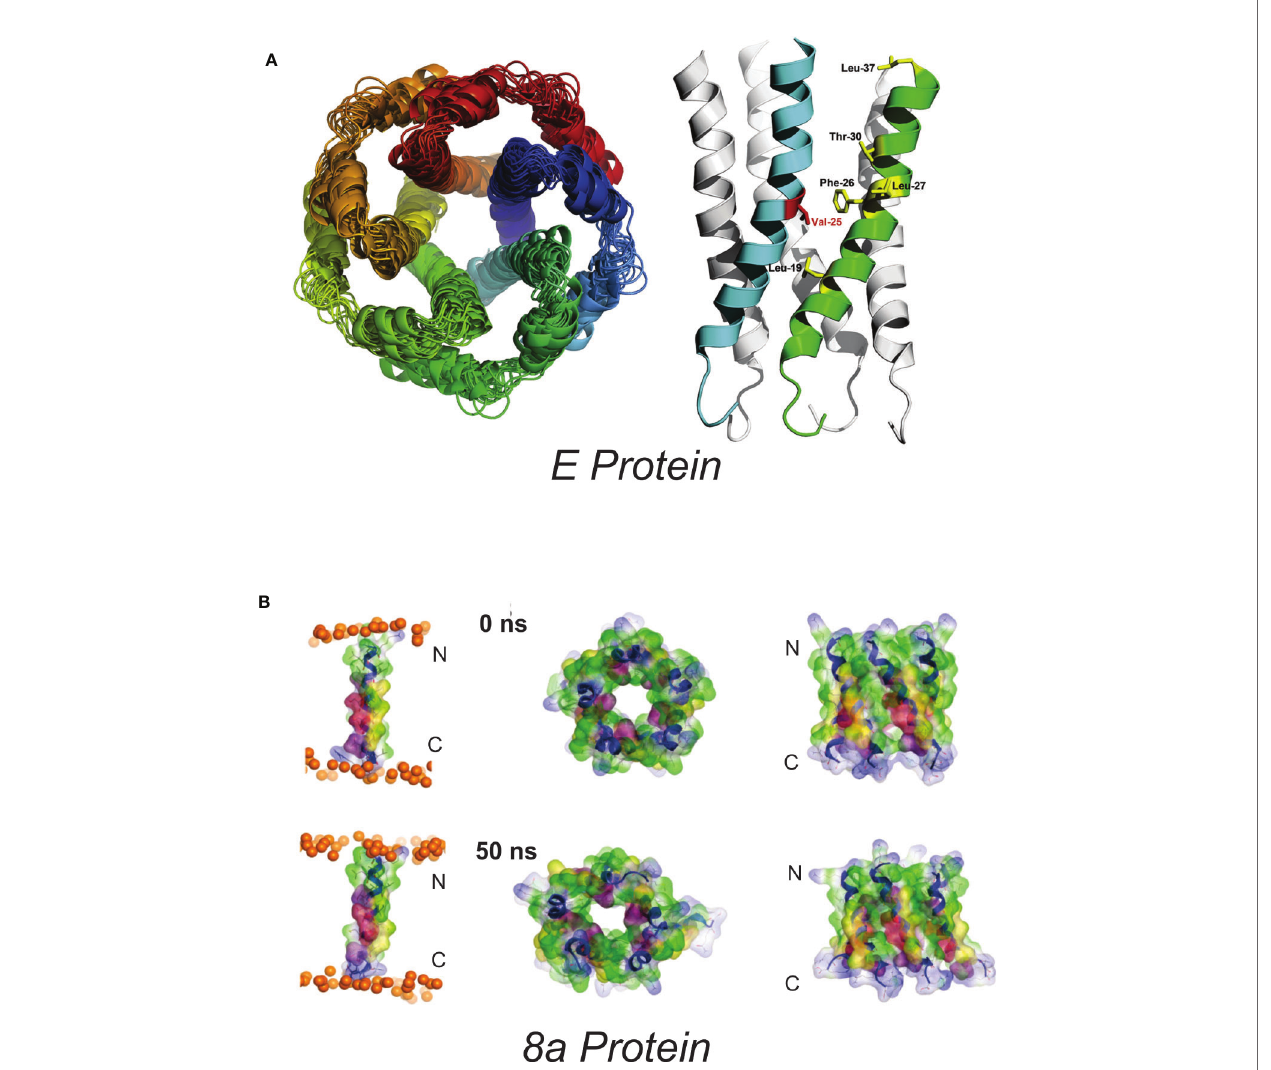
FIGURE 1 | Proposed SARS-Cov E and 8a structures (A) Proposed homopentameric structure of the E protein (32), viewed ( left ) through the membrane, and ( right ) on the plane of the membrane. The structural model includes a ~2Å radius constriction, formed by the sidechains of V25 and V28, which could conceivably act as a channel gate, and an extended central “ pore ” of <6Å in radius (34) [From Surya et al. BBA-Biomembranes 2018 1860: 1309-1317. With publisher ’ s permission] (B) . Proposed pentameric structure of the 8a protein. ( left ) The single transmembrane domain (TMD) 8a 1 – 22 is shown at the beginning (0 ns) and end of a 50-ns MD simulation, ( right ). Top view (left) and side view (right) of a pentameric bundle of 8a 1 – 22 at the beginning (upper) and end of 50 ns MD simulation (lower). The protein backbones are drawn in blue with the side chains shown as sticks and van der Waals surface representation. Residues Thr-8, Ser-11, and 214 are shown in pink and light red, respectively. All cysteine residues, Cys-9, 213, and 217, are shown in yellow. Phosphorous atoms of the lipids are shown in orange spheres. Lipid and water molecules are omitted for clarity. [Relabeled from Hsu et al., Proteins . 2015; 83: 300 – 308. With publisher ’ s